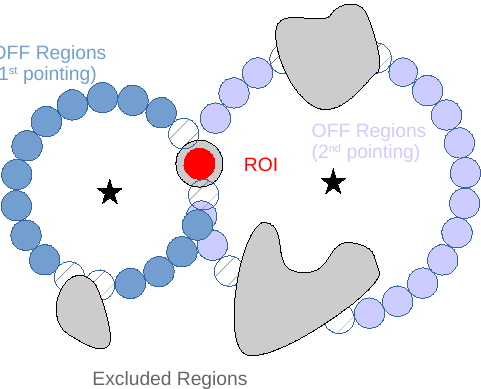
Figure 11. Illustration of the reflected regions background, for two different observation positions (shown as black stars). The positions of the selected OFF regions are shown as filled circles. The excluded regions, which have non-empty overlap with excluded regions (displayed in grey) are shown as dashed